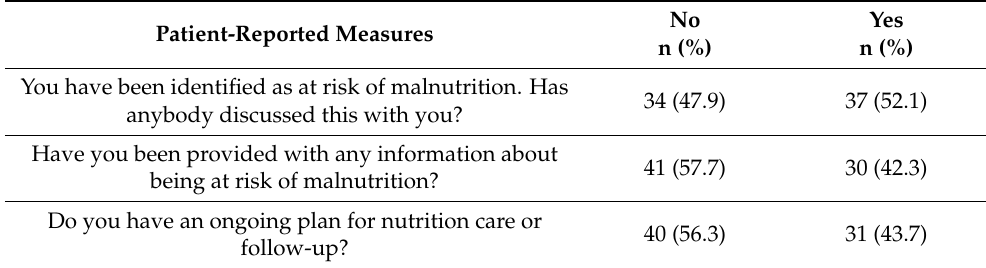
Table 3. Patient-reported measures for key components of the nutrition care